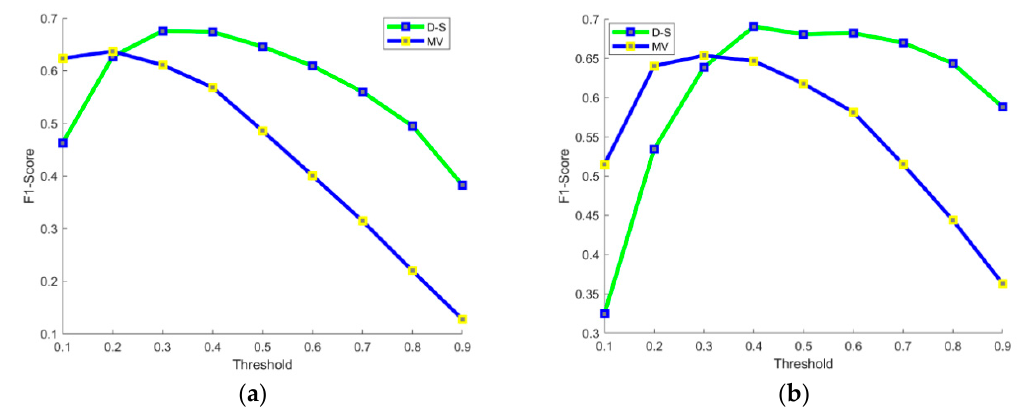
Figure 9. Sensitivity analysis of the threshold for OBCD: ( a ) experiment 1 and ( b ) experiment 2.